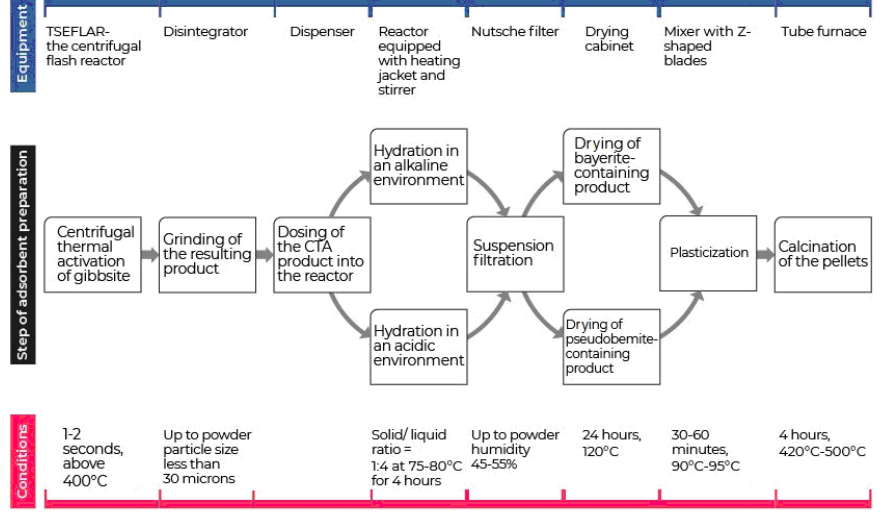
Figure 3. Technological stages of obtaining aluminium oxide adsorbents using the centrifugal thermal activation (CTA) method.